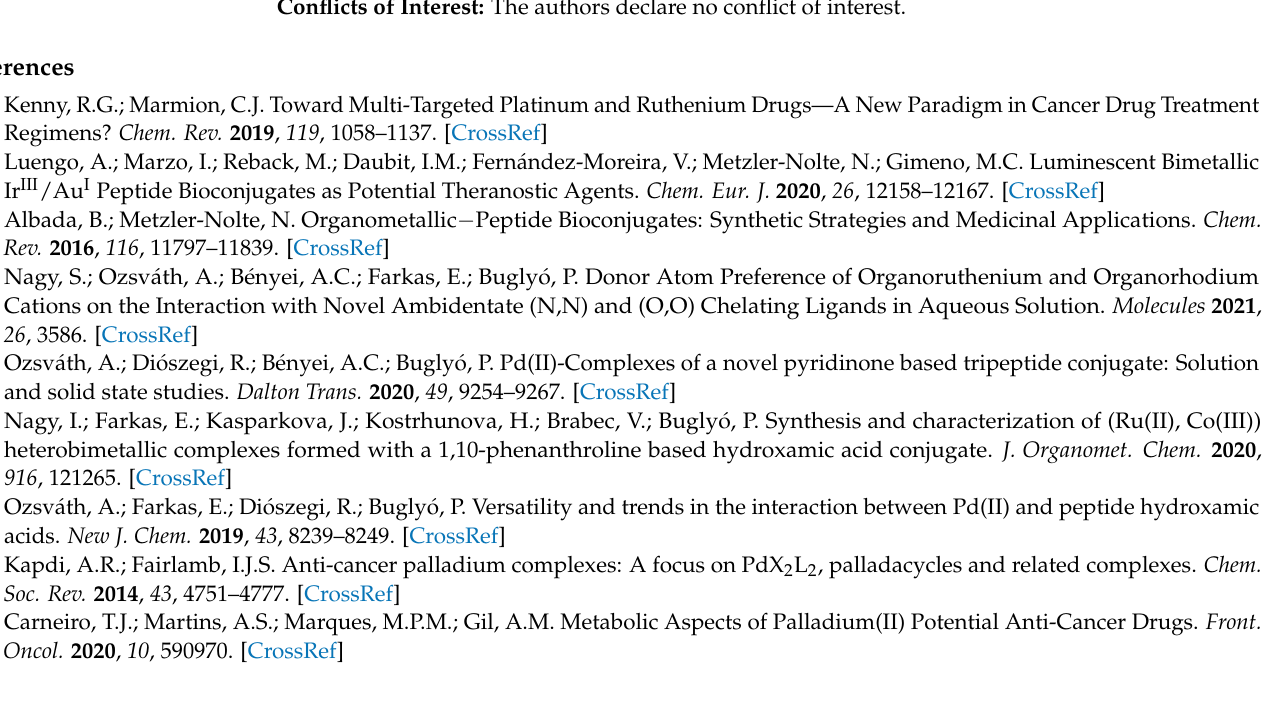
Figure S2: 1 H NMR spectrum of H(L1) · CF 3 COOH, registered in D 2 O; Figure S3: 13 C NMR spectrum of H(L1) · CF 3 COOH, registered in D 2 O; Figure S4: pH-dependence of the 1 H NMR signals belonging the Ala methyl (red) and pyridinone ring hydrogen (blue).; Figure S5: Suggested solution structures of the various